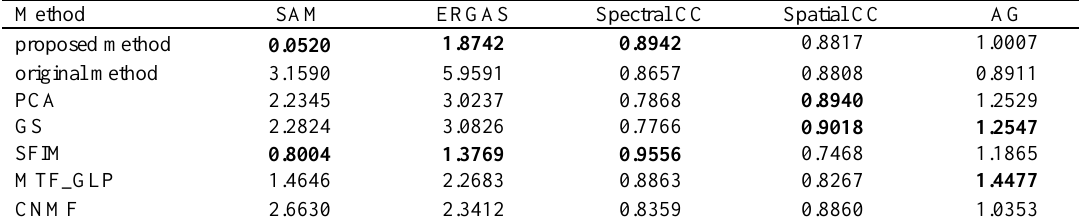
Table 2. Evaluation indexes of dataset